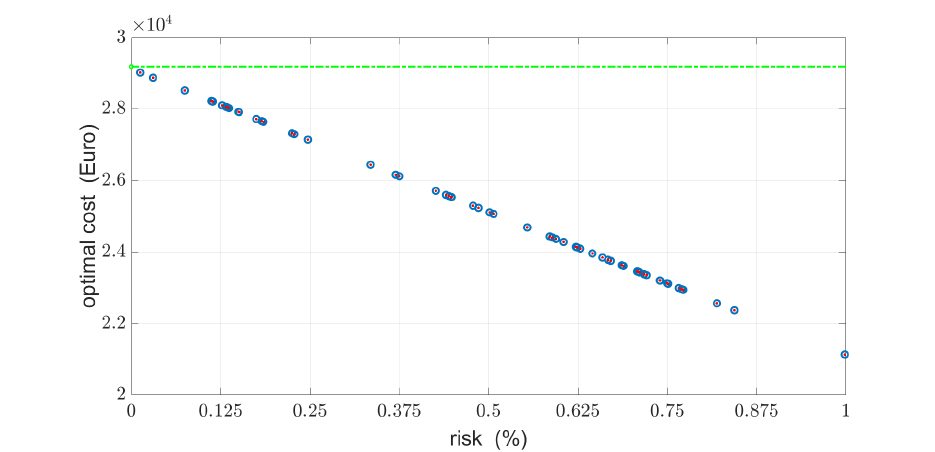
Figure 3. Optimality versus Risk (distance).